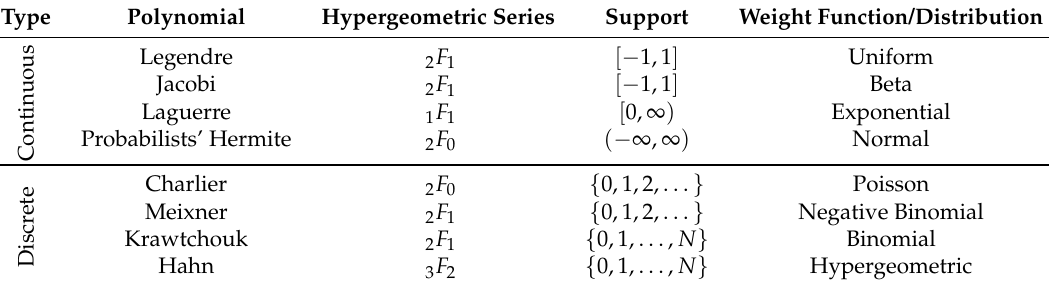
Table 1. Common Orthogonal